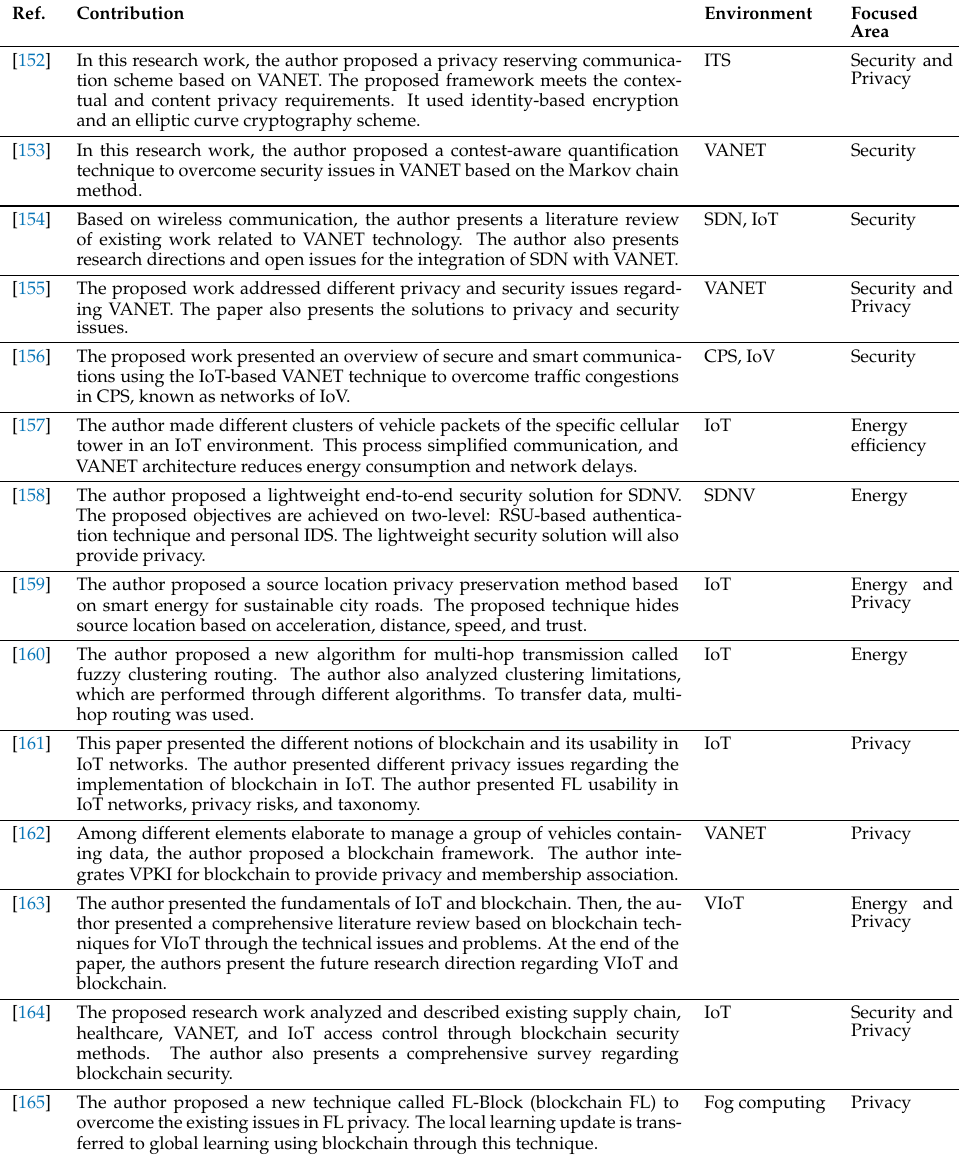
Table 4. Literature review of security, privacy, and energy